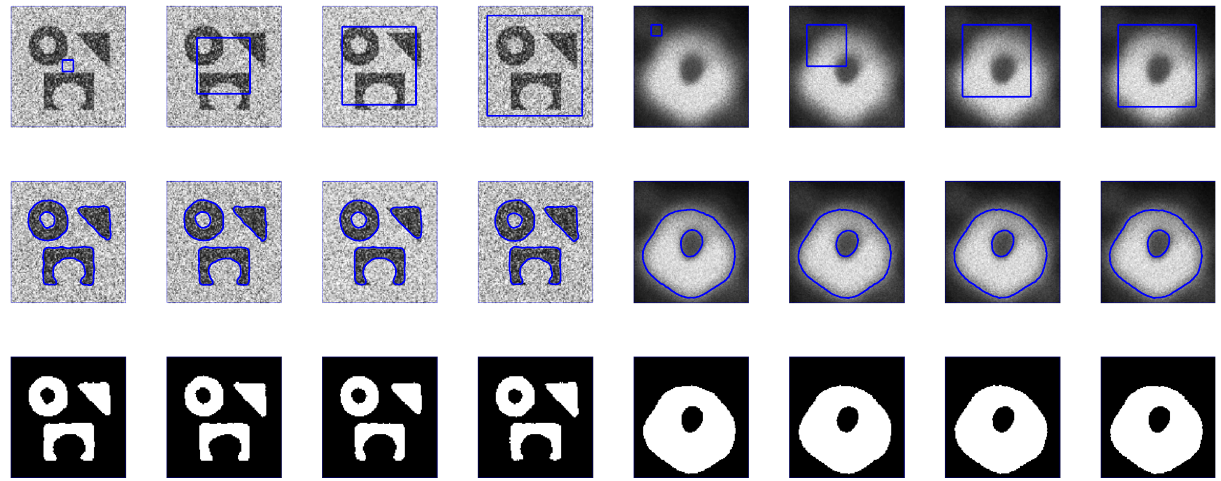
Figure 1. Illustration of the proposed segmentation method for the first ever black hole image and noisy images taken from 31,36 papers. First row: different initial contours. Second row: final contours. Third row: segmented results with p = 0.5 , µ = 0.7, and σ = 3.